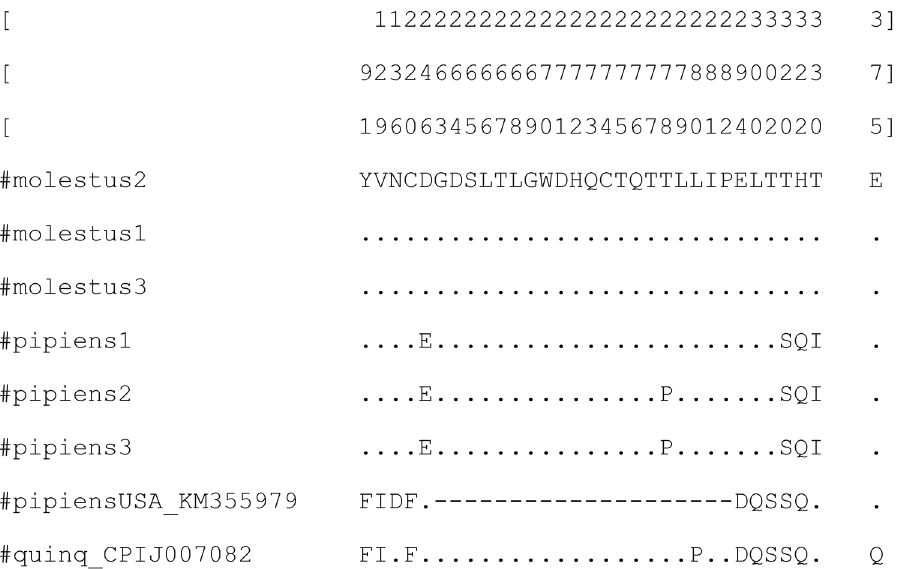
Figure 2. Variations of amino acid sites in the gene tim from C. pipiens . C.pipiens from the USA (KM355979), and C.quinquefasciatus (CPIJ007082) are taken for the comparison. Dashes show deletion in exon 1 in C. pipiens from the USA (KM355979). Exon 1 (sites 1-345) and exon 5 (sites 347-472) are separated by blank columns. Positions of the variable sites in combined tim sequences shown on the